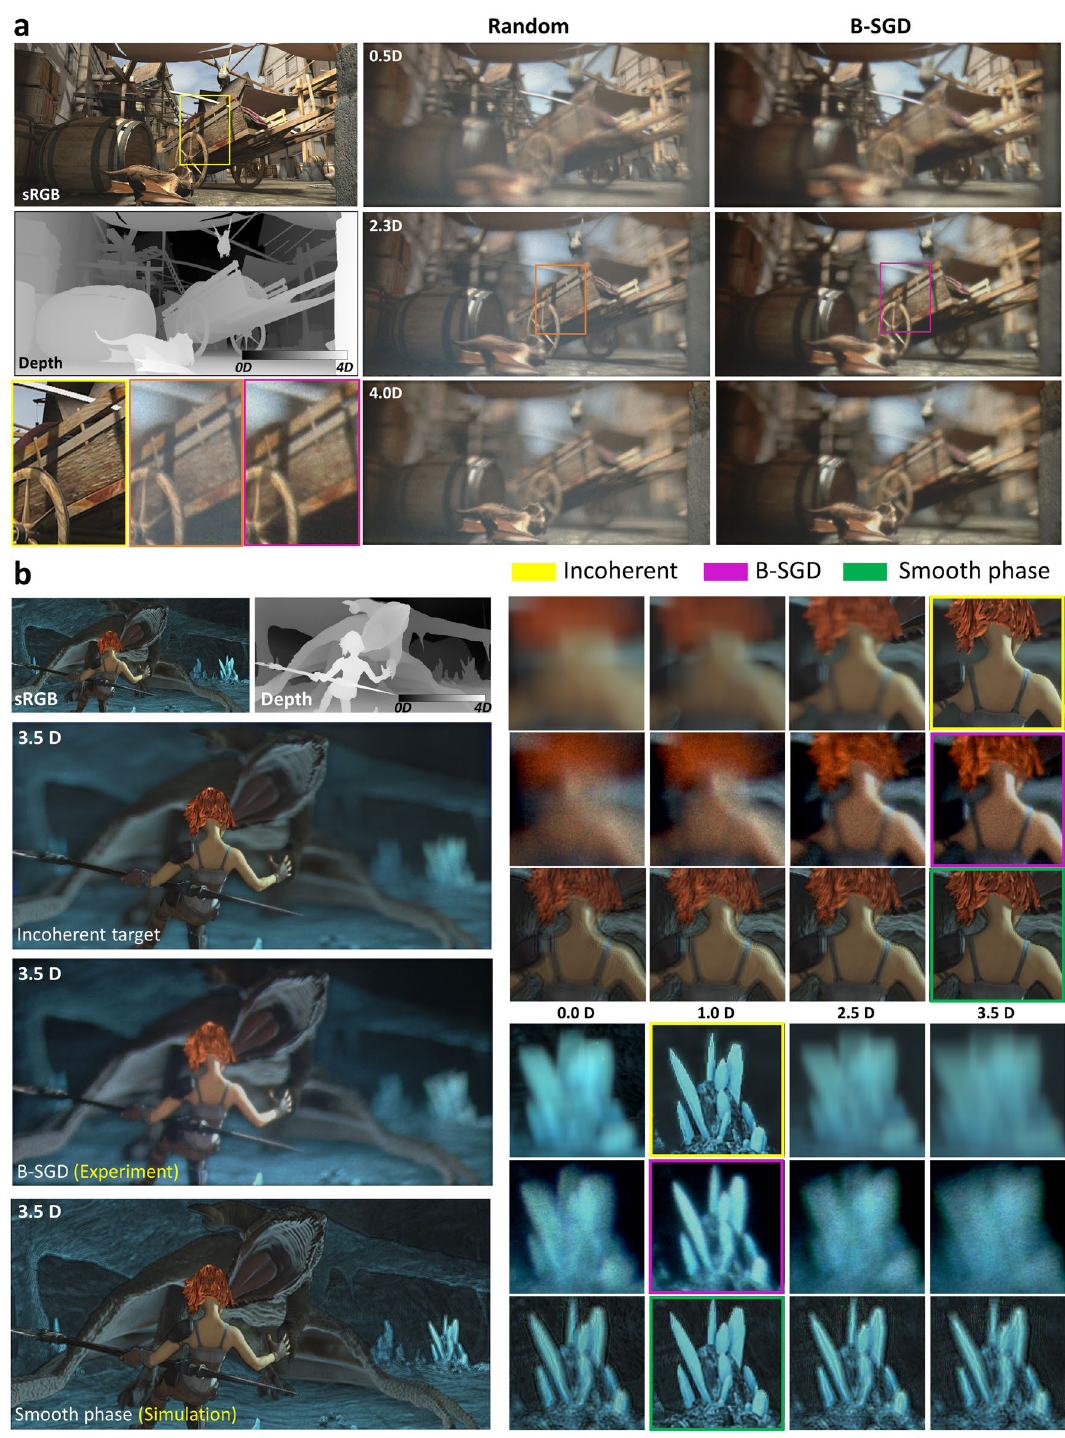
Figure 4. Experimental results for 3D scenes whose depth range extends between 0.0D and 4.0D. ( a ) Three example focal sweep scenes when the camera is focusing on 0.5D, 2.3D, 4.0D without/with optimization. ( b ) Comparisons with incoherent 3D target and simulated smooth phase holography. Focal sweep results are summarized in right figures where focused images are noted as dot boxes. Our prototype shows realistic focus cues well match the 3D target. On the other hands, smooth phase fails to provide accurate focus cues. The source data by © copyright Blender Foundation |